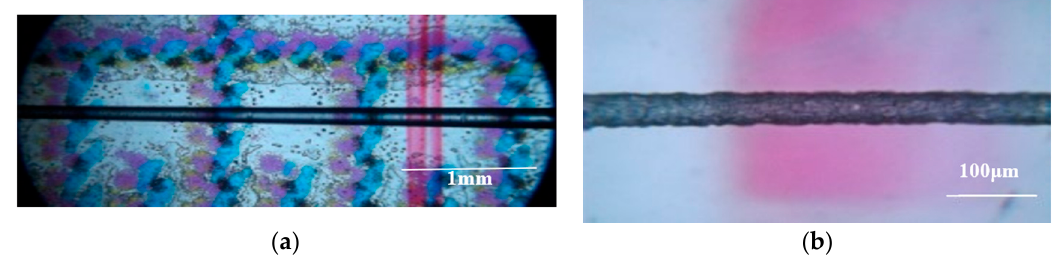
Figure 6. ( a ) Microscope pictures of fiber down-tapers section magnified x10, ( b ) along the taper waist magnified ×40.